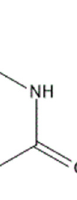
Figure 1. Chemical structure of 5-fluorouracil.